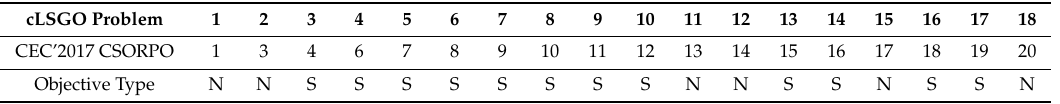
Table 2. Scaled optimization problems for the constrained large-scale global optimization (cLSGO) benchmark